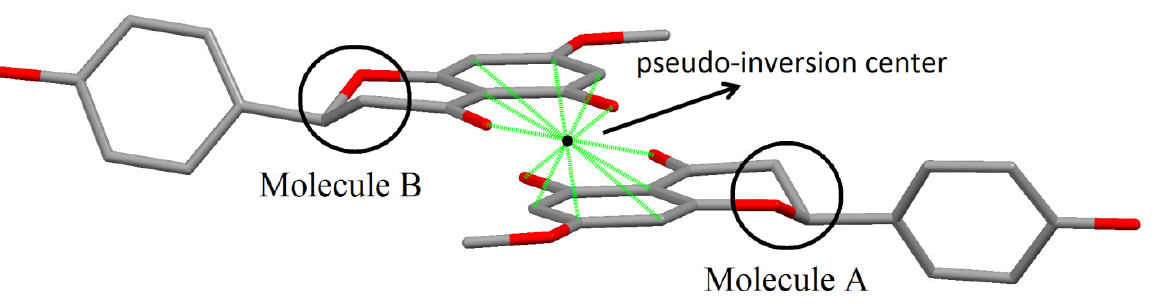
Figure 5. Details of molecules A and B in sakuranetin-monohydrate related to the pseudo-inversion center. Solid green lines show atoms related by the inversion center (black point). The inversion symmetry is forbidden for the stereogenic atoms C10 and C26 in the homologous chromane rings (highlighted by